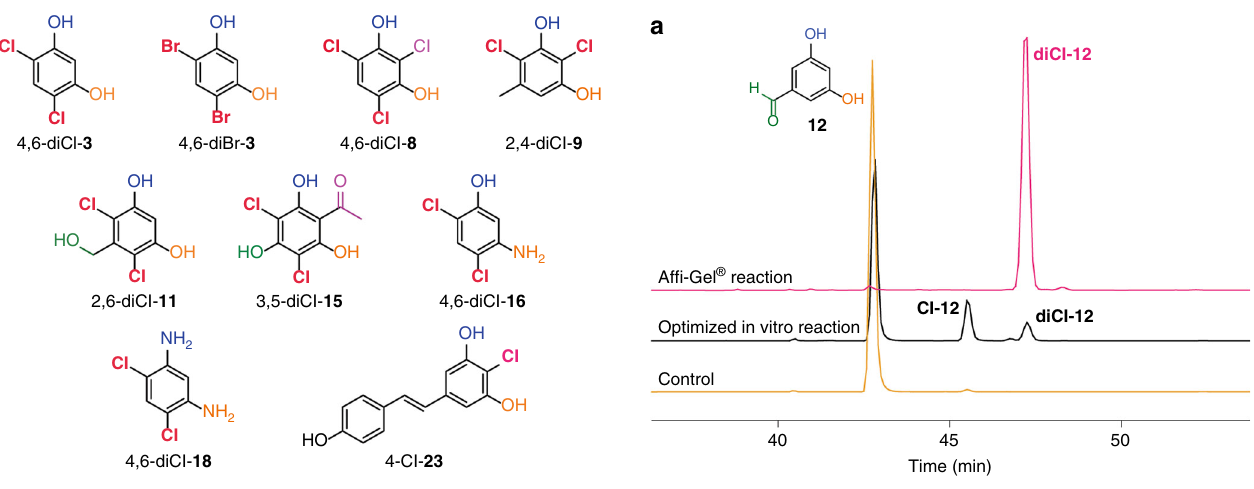
Fig. 6 Structures of the products of halogenation by PltM. Structures, as determined by NMR spectroscopy, of products resulting from the halogenation of compounds 3 , 8 , 9 , 11 , 15, 16 , 18 , and 23